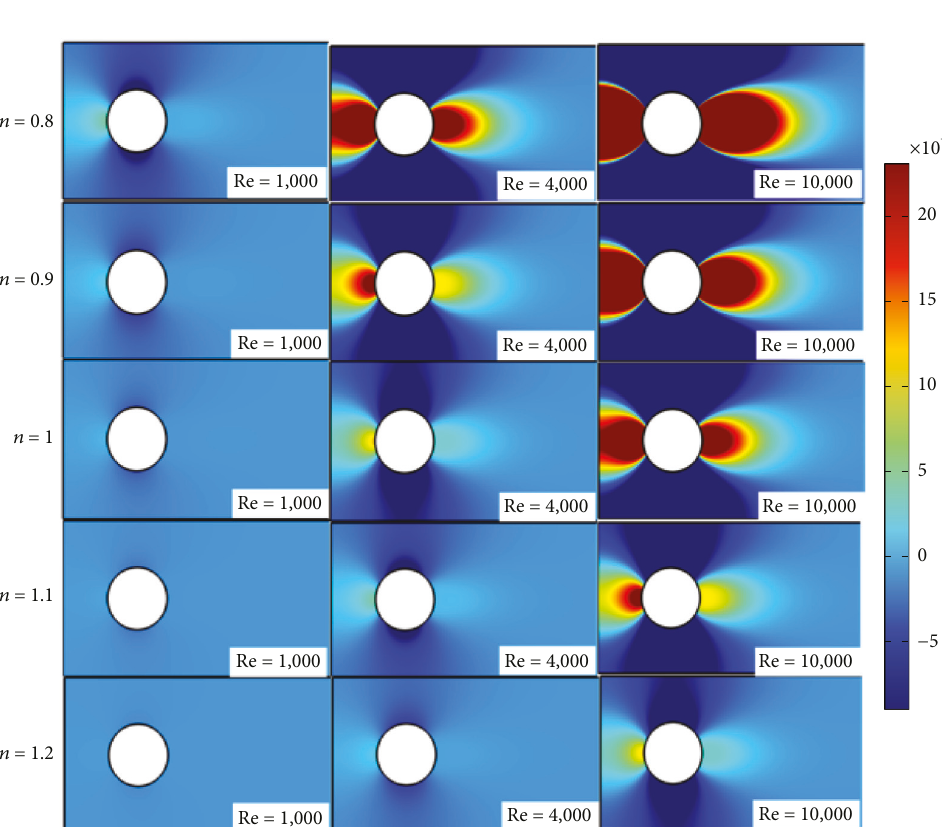
Figure 8: Pressure distribution near the heated cylinder with radius r � 0 .